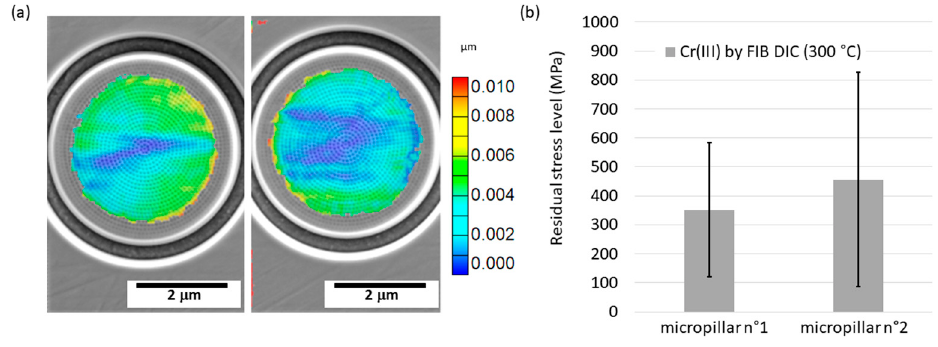
Figure 8. ( a ) Amplitude of displacement field measured on micro-pillars after FIB milling. ( b ) Results of the FIB-DIC residual stress level measurements on crystallized trivalent chromium.